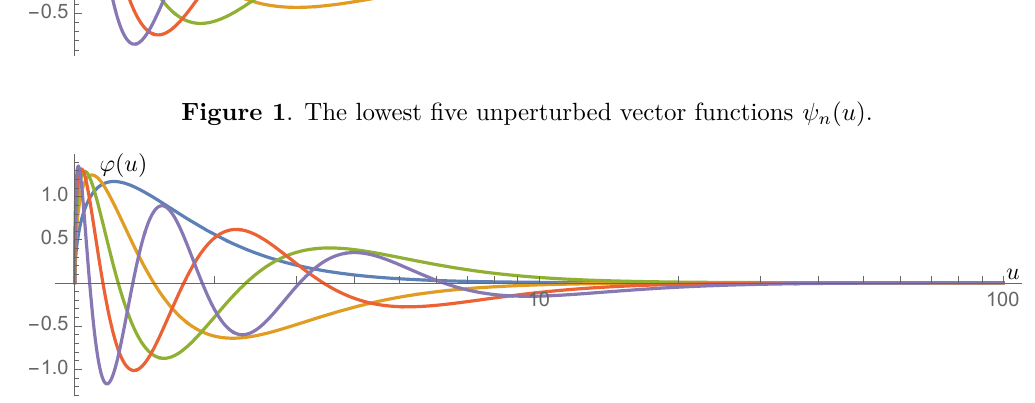
Figure 2 . The lowest five unperturbed scalar functions ϕ j ( u )